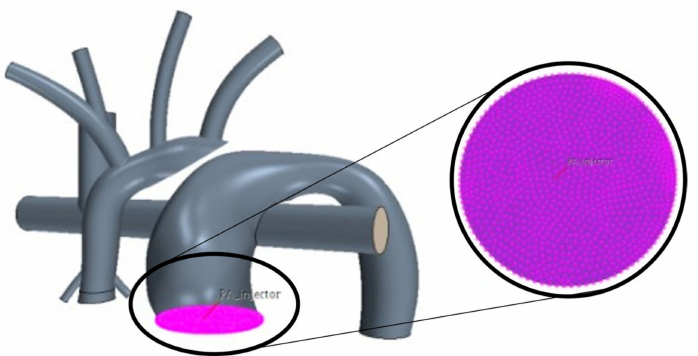
Figure 13. Injection grid located in the main pulmonary artery. Particles were released with zero injection velocity at random across the grid (in space) and at random across the cycle (in time). The release of particles from each node of the grid was controlled by the point inclusion probability function built-in StarCCM+, which regulates which nodes on the injection grid release a particle at any given time